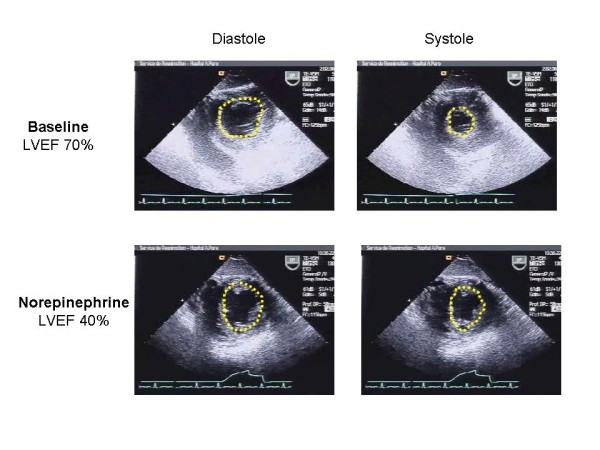
Short-axis view of the left ventricle by a transgastric approach in a patient with septic shock at baseline after initial resuscitation and after a few hours of norepinephrine infusion. Note that restoration of a "normal" left ventricular afterload has unmasked impaired contractility. LVEF, left ventricular ejection fraction.